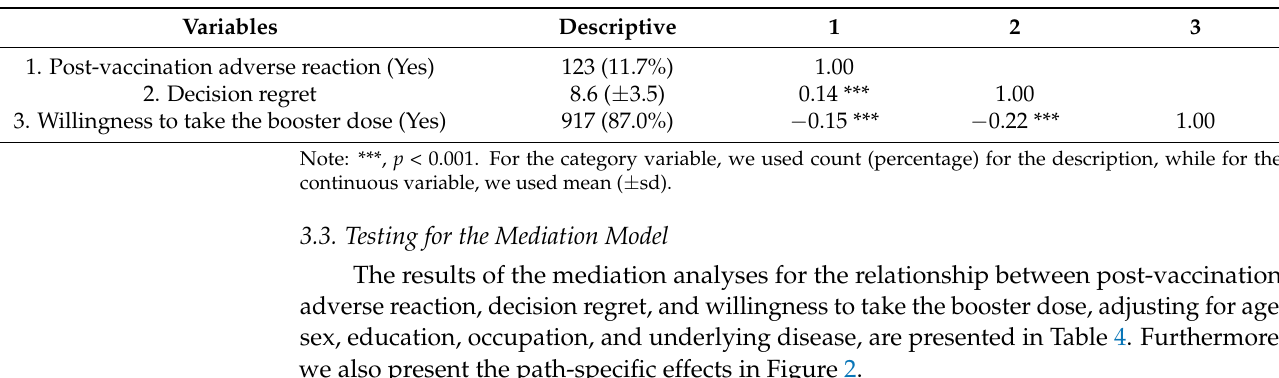
Table 3. Descriptive statistics and correlations among study variables ( n = 1054).